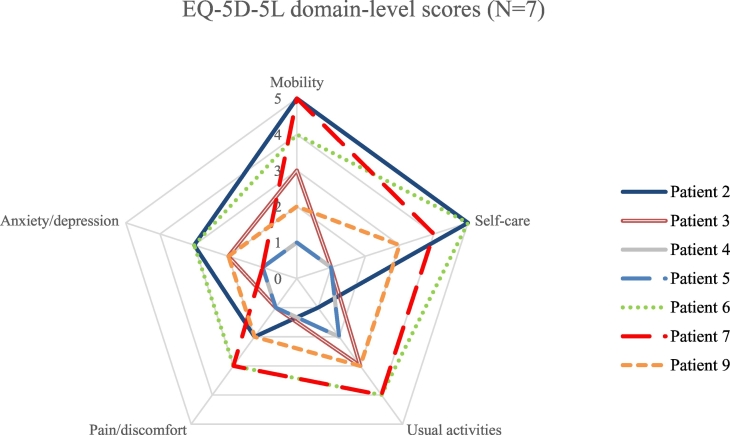
HRQoL by domain of seven patients as reported by proxy measured using the EQ-5D-5 L questionnaire. Each line represents the carer-reported domain score by proxy for an individual patient (N = 7). Please note that identical scores were reported for patients 4 and 5 so these appear to be one line. Responses for the EQ-5D-Y questionnaire were completed for two patients; these are not represented here as each dimension on the EQ-5D-Y has three levels compared with five levels on the EQ-5D-5 L. Higher scores indicate a higher level of perceived problems for that domain of the EQ-5D-5 L questionnaire. Abbreviations: EQ-5D-5 L, EuroQol 5 Dimensions 5 Levels; EQ-5D-Y, EuroQol-5 Dimension-Youth; HRQoL, health-related quality of life.